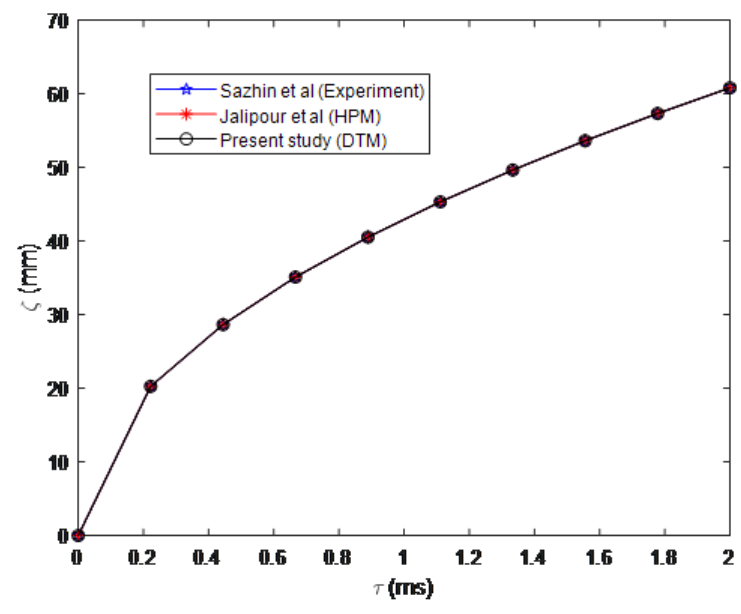
Figure 11. Validation and Comparison of